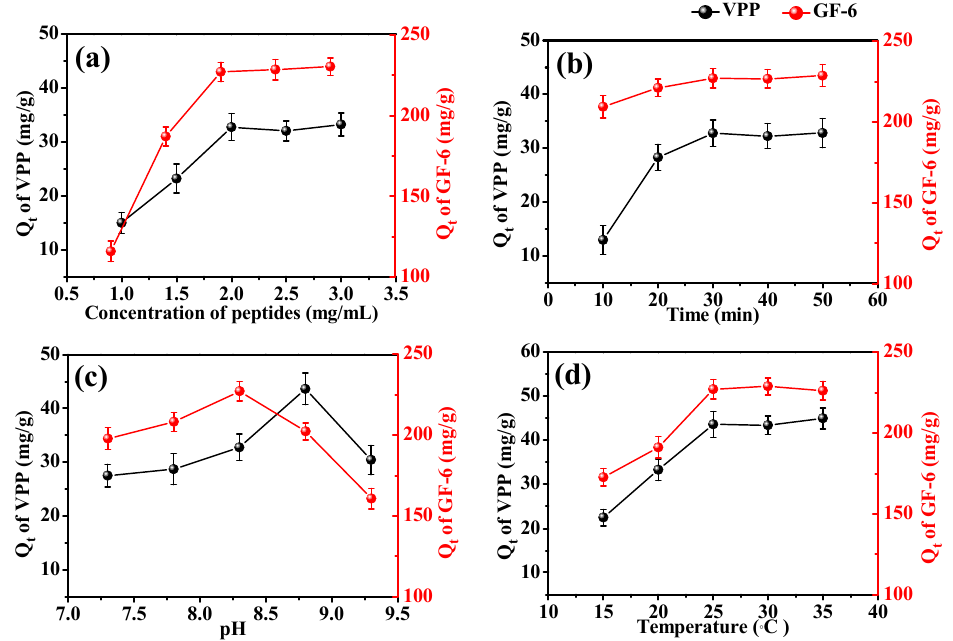
Figure 6. Effects of peptides concentration ( a ), time ( b ), pH ( c ) and temperature ( d ) on the adsorption of AmZPP 5000 on VPP and GF-6.